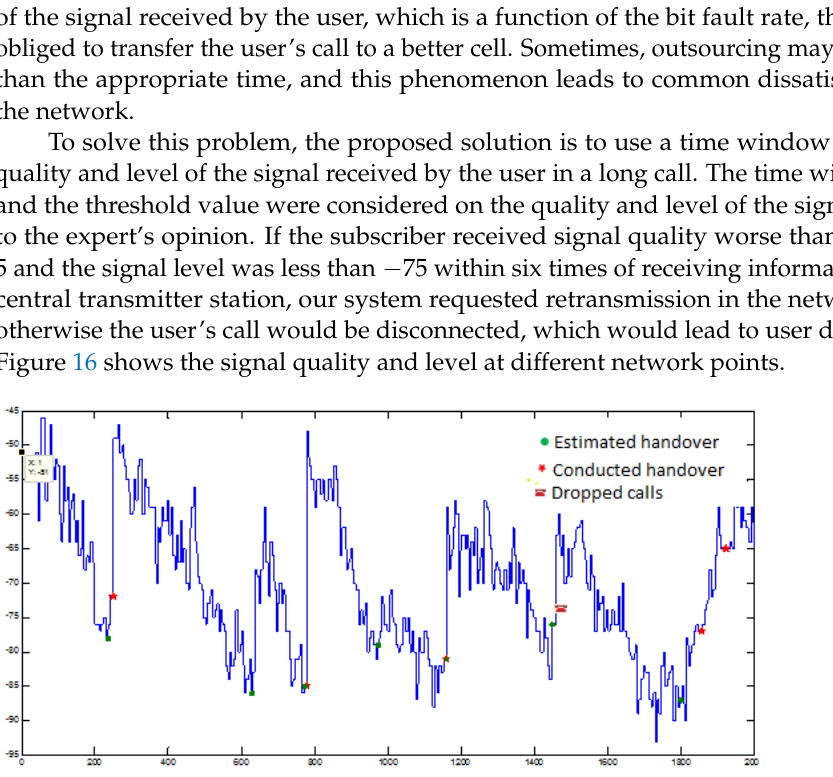
Figure 16. Silhouette coefficient value of different clustering methods–long call scenario.